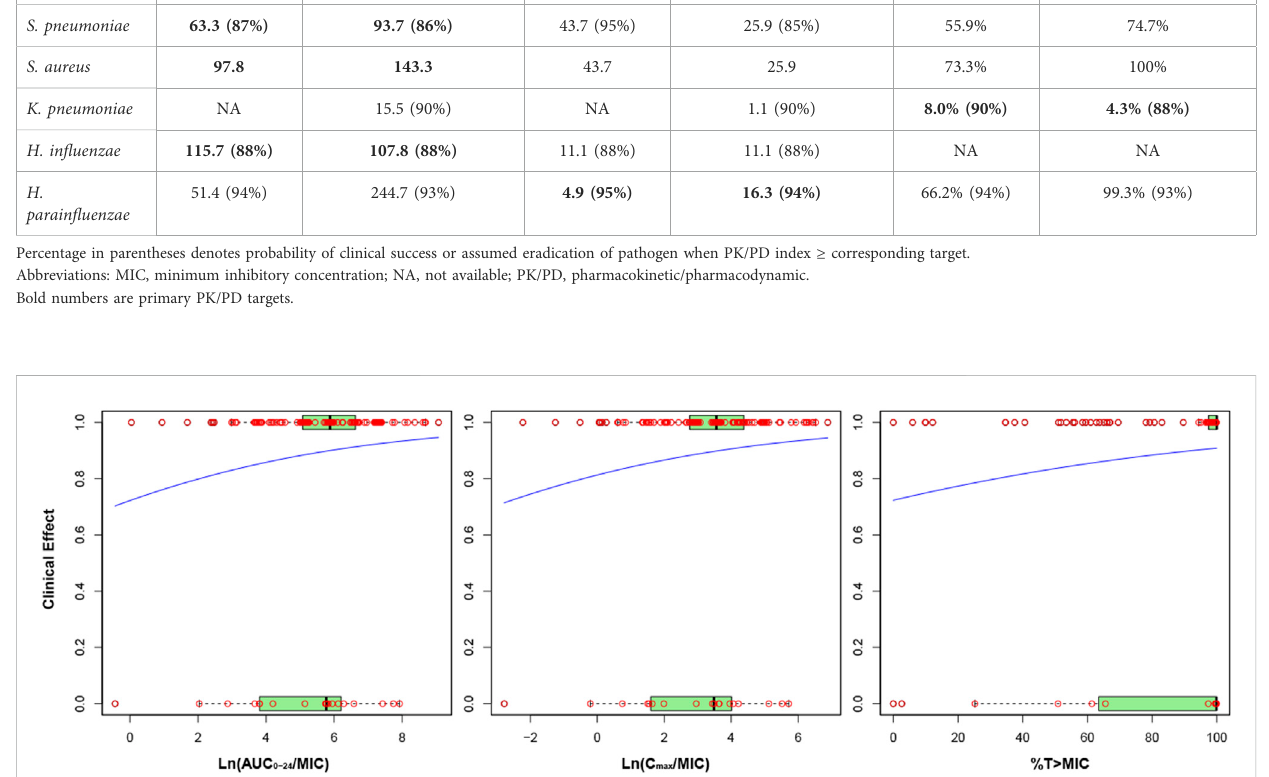
Correlation between nemonoxacin PK/PD index and clinical ef fi cacy. Y axis indicates probability of successful clinical ef fi cacy. Red circles indicate actual data, and blue line indicate fi tting from the logistic regression model. The box plot with light green characterizes the distribution pattern of actual data: the left limit, inner line and right limit of box are 25%, 50% and 75% percentile of actual data, respectively.